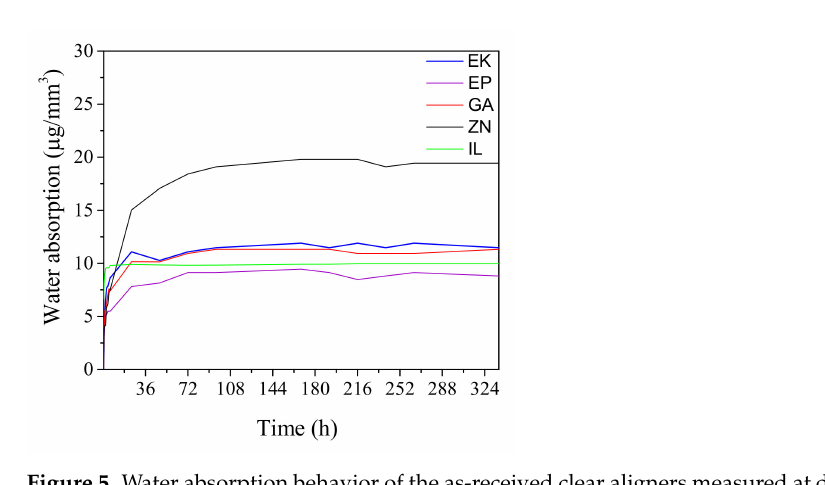
Figure 4. UV-visible absorbance curves of the as received clear aligners. Erkodur (EK); Essix Plastic (EP); Ghost Aligner (GA); Zendura (ZN); Invisalign (IL). The water absorption behavior of the clear aligners, measured at different immersion times, is reported in Figure 5.